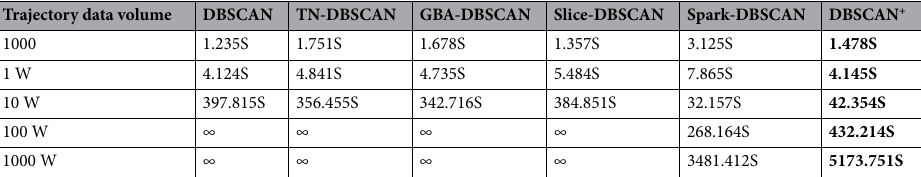
Table 2. Time performance of each density clustering algorithm. The bold indicates that the algorithm proposed in this paper is better than other algorithms.